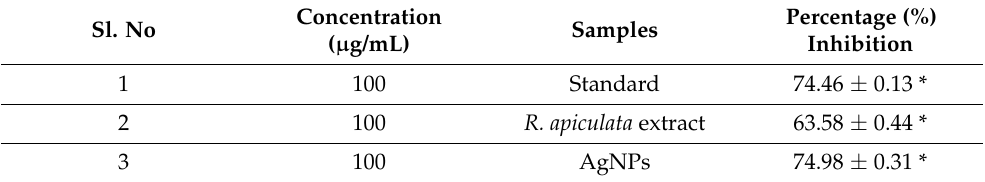
Table 3. H 2 O 2 assay of aqueous leaf extract of R. apiculata and its synthesized AgNPs.